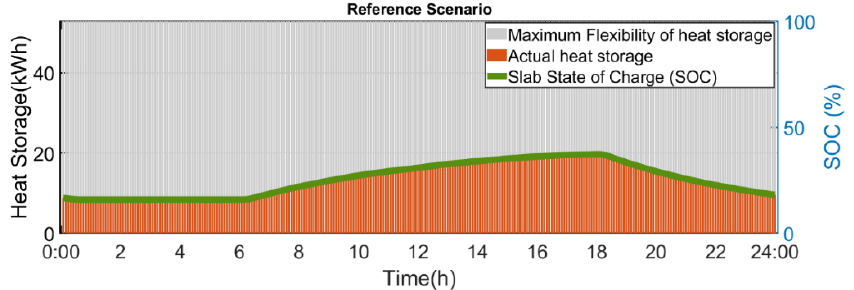
Figure 17. Heat storage and state of charge (SOC) of the slab (reference case).